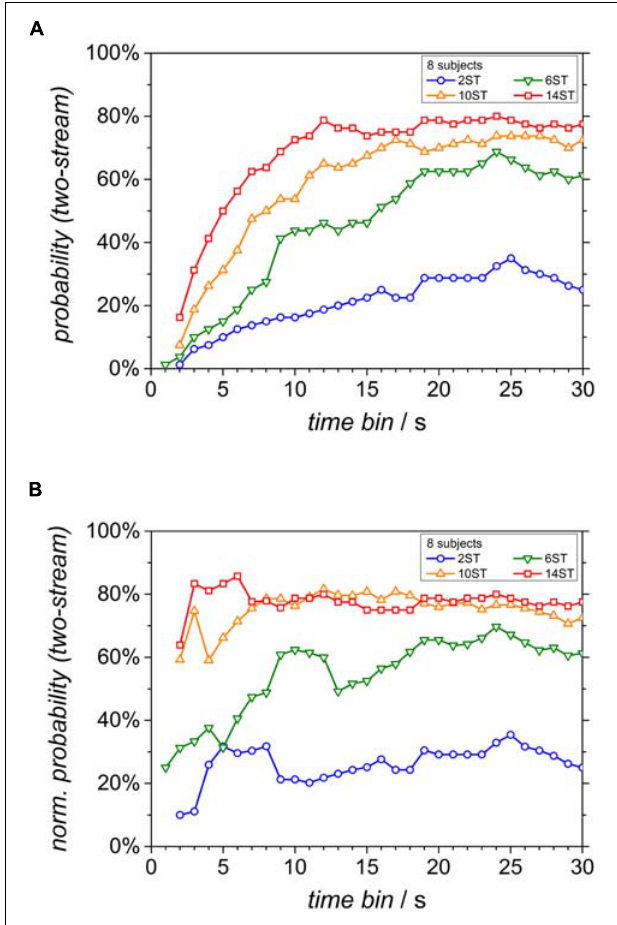
FIGURE 4 |Time courses of the current probability of the two-stream percept for the different (cid:2) f conditions. (A) Conventional display and (B) normalized probability, rescaled by the probability that any response has been given yet (see